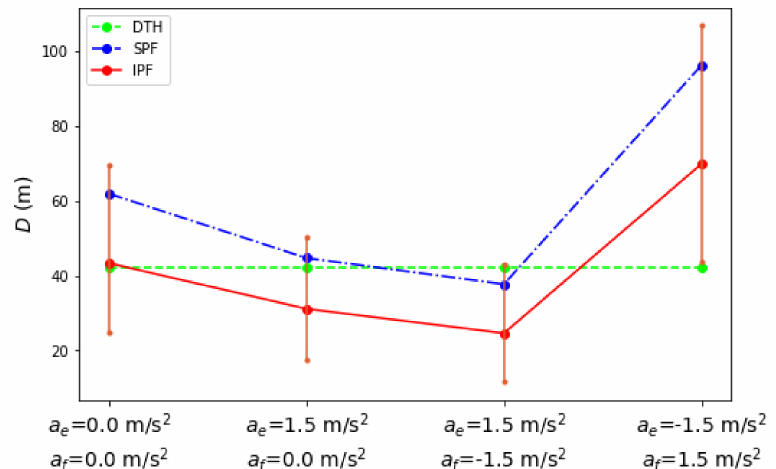
Figure 9. The comparison of the critical distance in DTH, SPF, and IPF. The green broken line and the blue broken line are the critical distance of vehicles in the DTH model and the SPF model, respectively. The red broken line is the critical distance of vehicles in the IPF model. In addition, the upper end of the red broken line